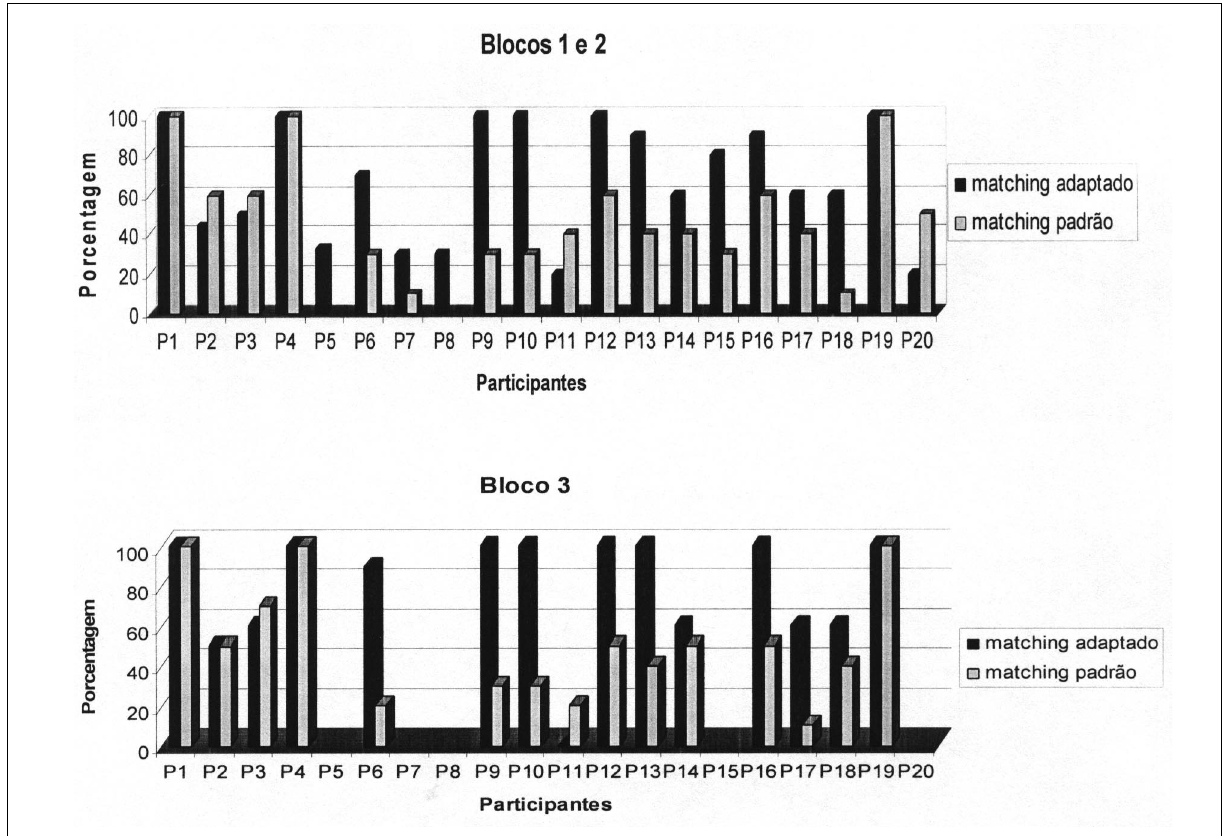
Figura 2. Porcentagem de acertos, de participantes individuais, no matching de identidade com o procedimento adaptado (barras pretas) e com o procedimento típico (barras cinza), nos Blocos 1 e 2, respectivamente (Painel superior) e no Bloco 3, com os dois tipos de tentativas misturadas ao longo da seqüência (Painel inferior) O terceiro bloco, no qual a apresentação das